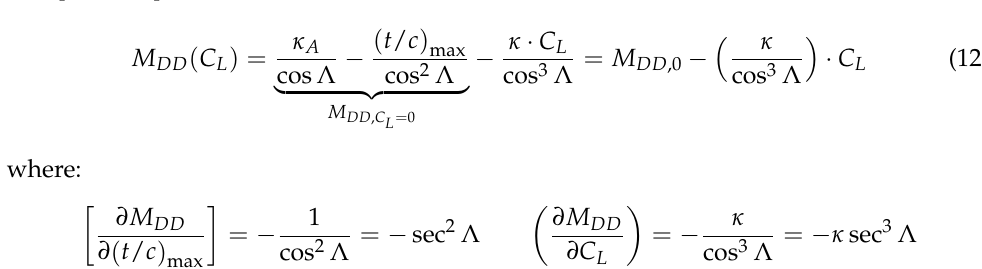
location; (t/c) max is the maximum airfoil relative thickness; and κ is a slope-factor usually